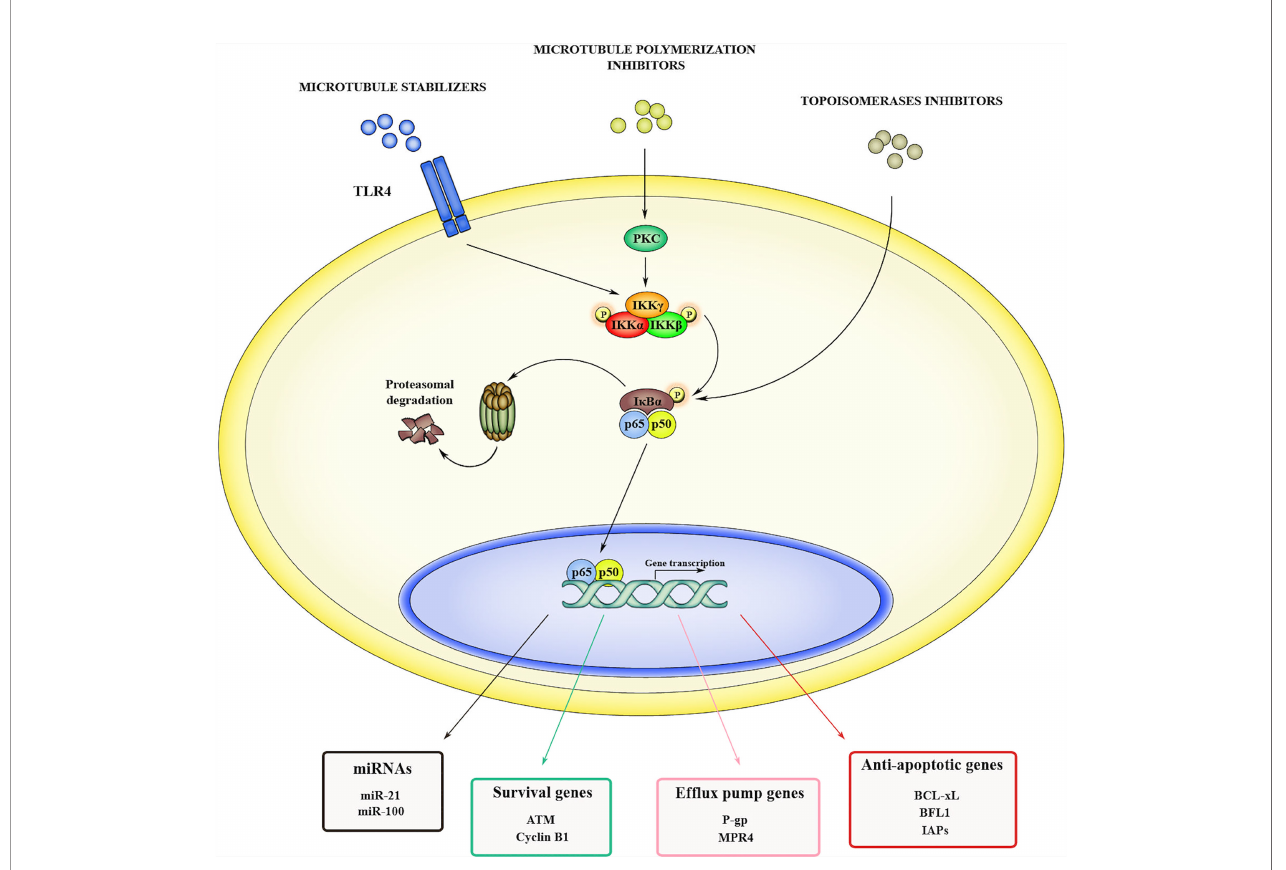
FIGURE 1 | Mechanisms of NF- k B-induced drug resistance. NF- k B can be activated in cancer cells in response to several anticancer drugs, including microtubule stabilizers ( i.e. , paclitaxel), microtubule polymerization inhibitors ( i.e. , vinblastine and vincristine) and topoisomerases inhibitors ( i.e. , doxorubicin and SN38). When activated, NF- k B promotes drug resistance by inducing the transcription of genes such as miRNAs, as well as genes codifying for prosurvival factors, anti-apoptotic effectors, and ef fl ux